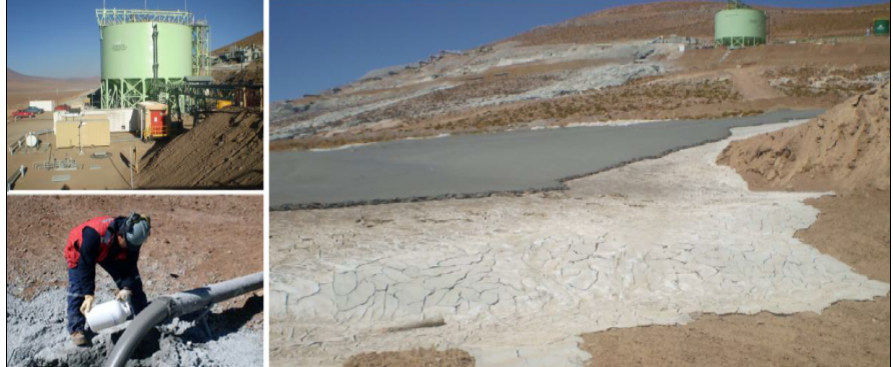
Figure 8. Paste Tailings Technology—Paste Tailings Demo Plant at Collahuasi Mine Chile [12].